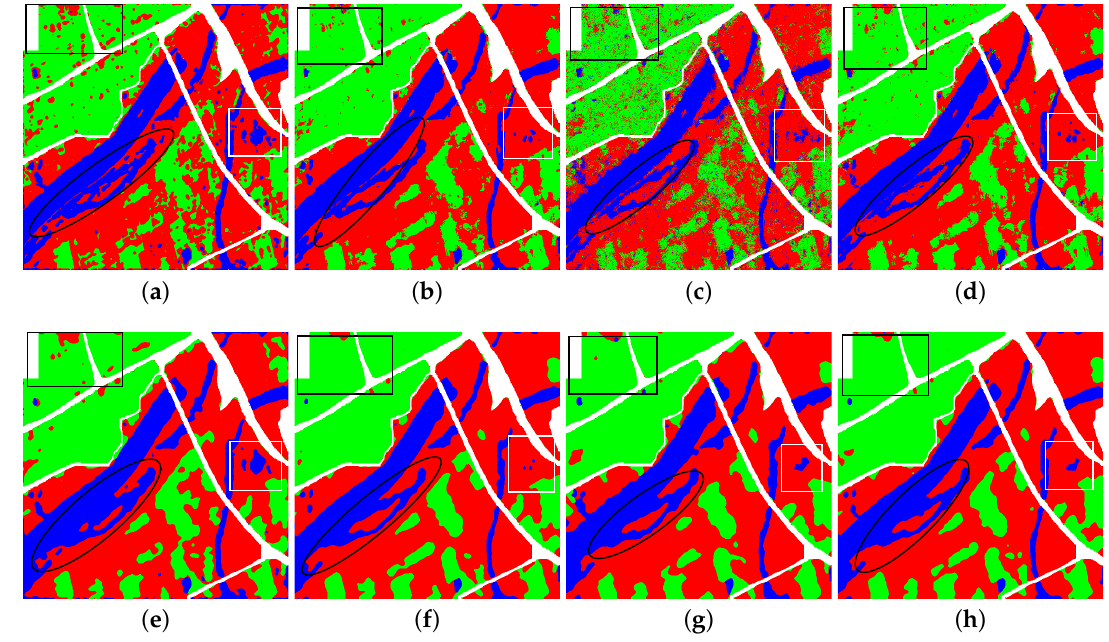
Figure 5. Classification result corresponding to the ground-truth of Xi’an area image obtained by different methods, including: ( a ) Wishart classifier; ( b ) SVM; ( c ) classification network based on AE; ( d ) classification network based on the proposed MAE; ( e ) Wishart classifier with PP step; ( f ) SVM with PP step; ( g ) AE with PP step; and ( h ) MAE with PP